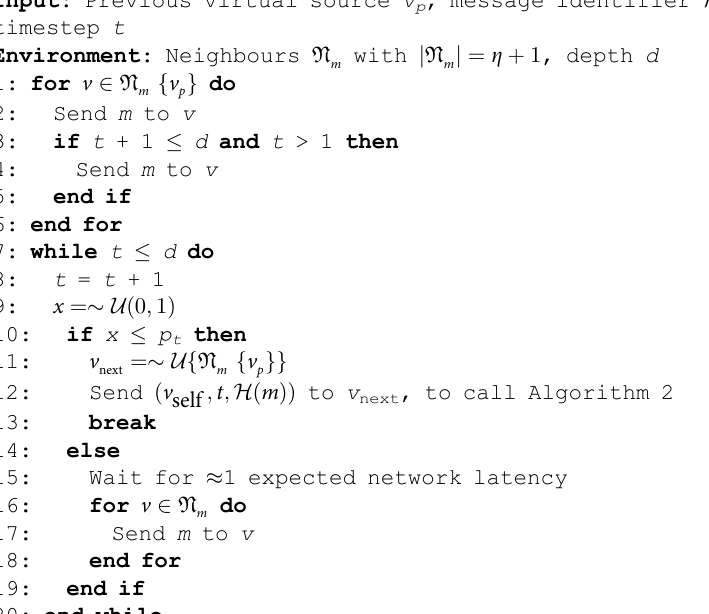
Algorithm 2 η -Adaptive Diffusion virtual source handling